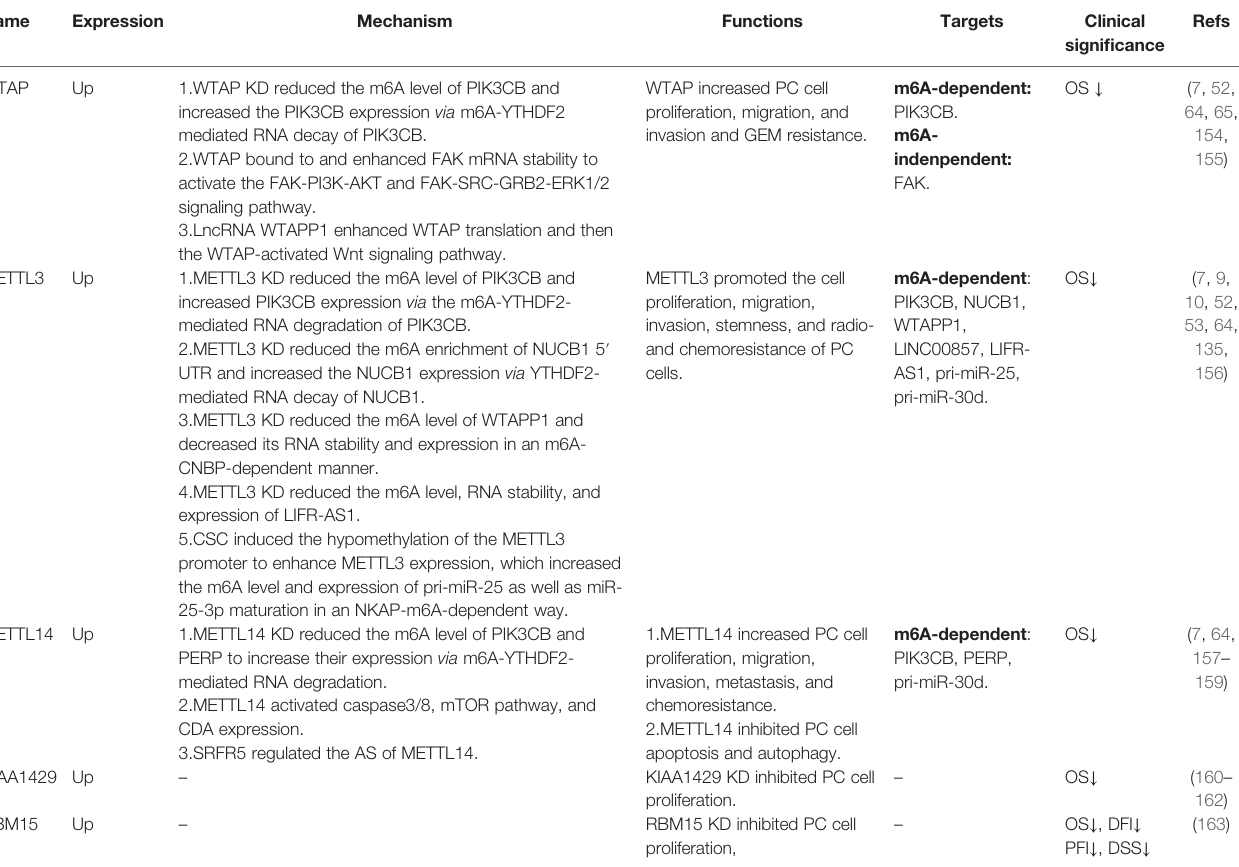
TABLE 3 | Functions of m6A writers in pancreatic